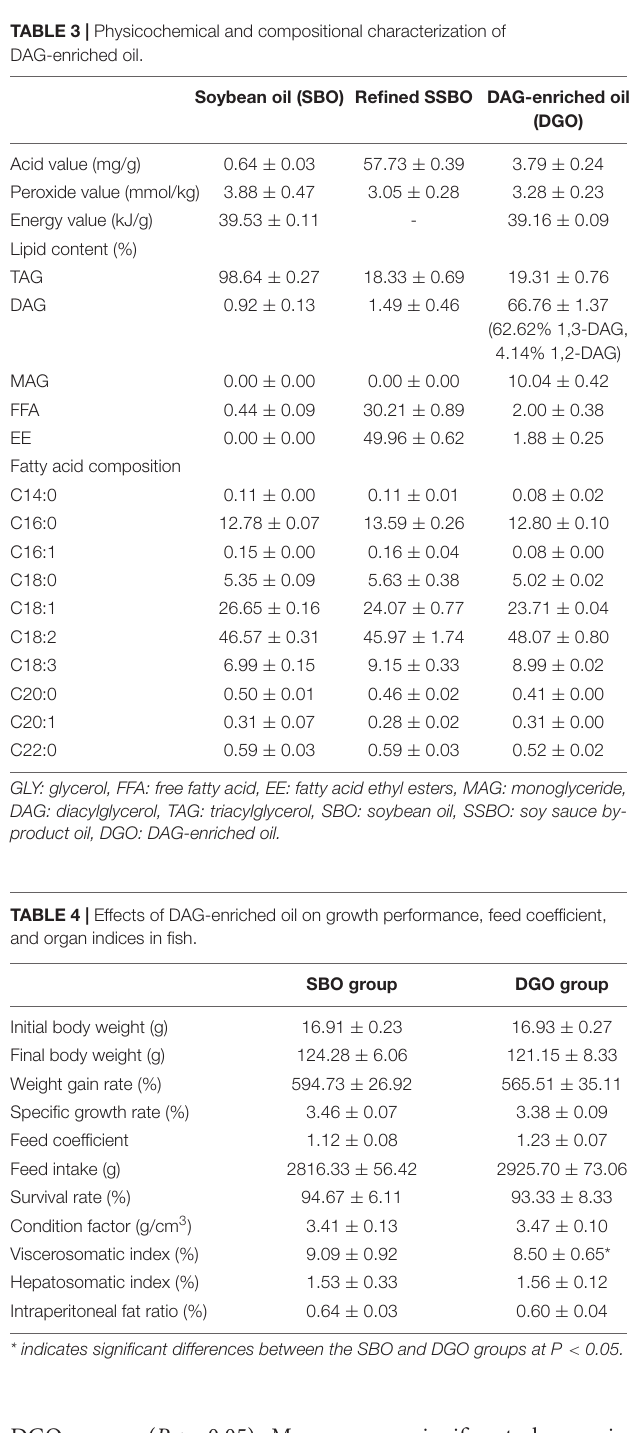
Effect of Dietary Diacylglycerol-Enriched Oil on Lipid Levels in Serum and